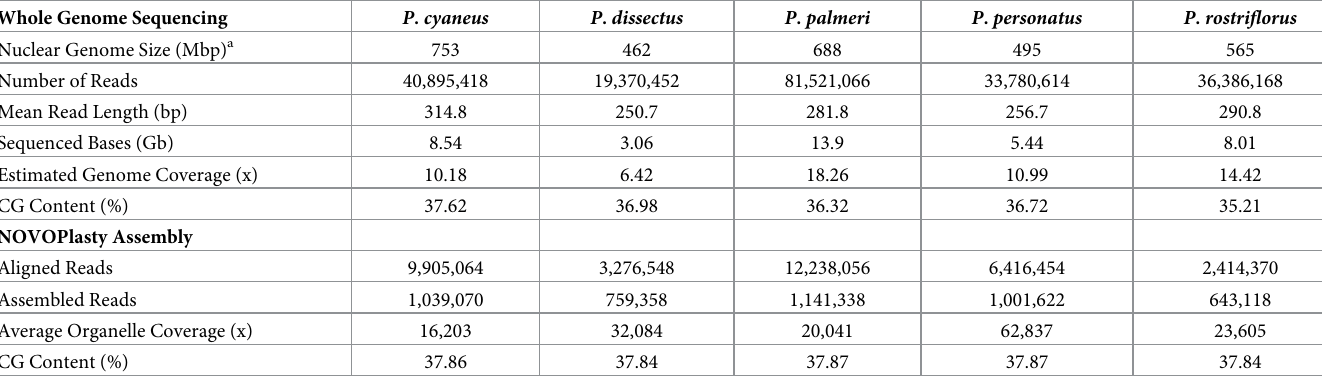
Table 2. Whole genome Illumina (250x250) pair-end sequencing results, and NOVOPlasty Penstemon plastome assembly reports. Whole Genome